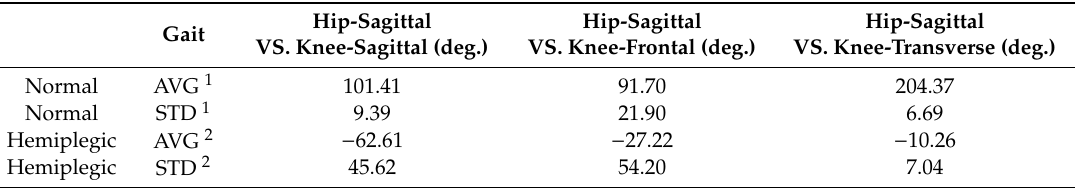
Table 1. The experimental results of the normalized gait phase angles with normal and simulated hemiplegic walking. Hip-Sagittal Hip-Sagittal Gait VS. Knee-Sagittal (deg.) VS. Knee-Frontal (deg.) VS. Knee-Transverse